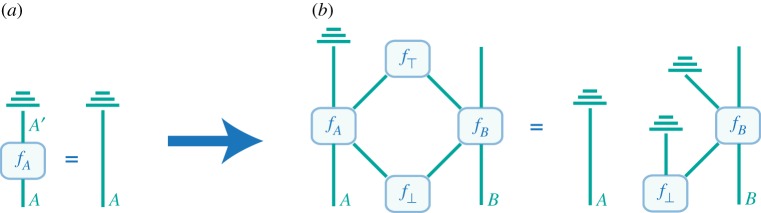
Terminality and non-signalling in process theories [7]. (a) Terminality: discarding a system A after applying a function fA is the same as discarding the system directly. (b) Non-signalling: in this set-up, a global preparation process f⊥ distributes two systems to Alice and Bob, who perform local operations fA and fB, respectively, on these systems and additional inputs A and B. Given terminality, if system A is discarded after this, no information about the original input on A can travel to system B. This holds even in the presence of an effect f⊤ acting on joint outputs of fA and fB. (Online version in colour.)